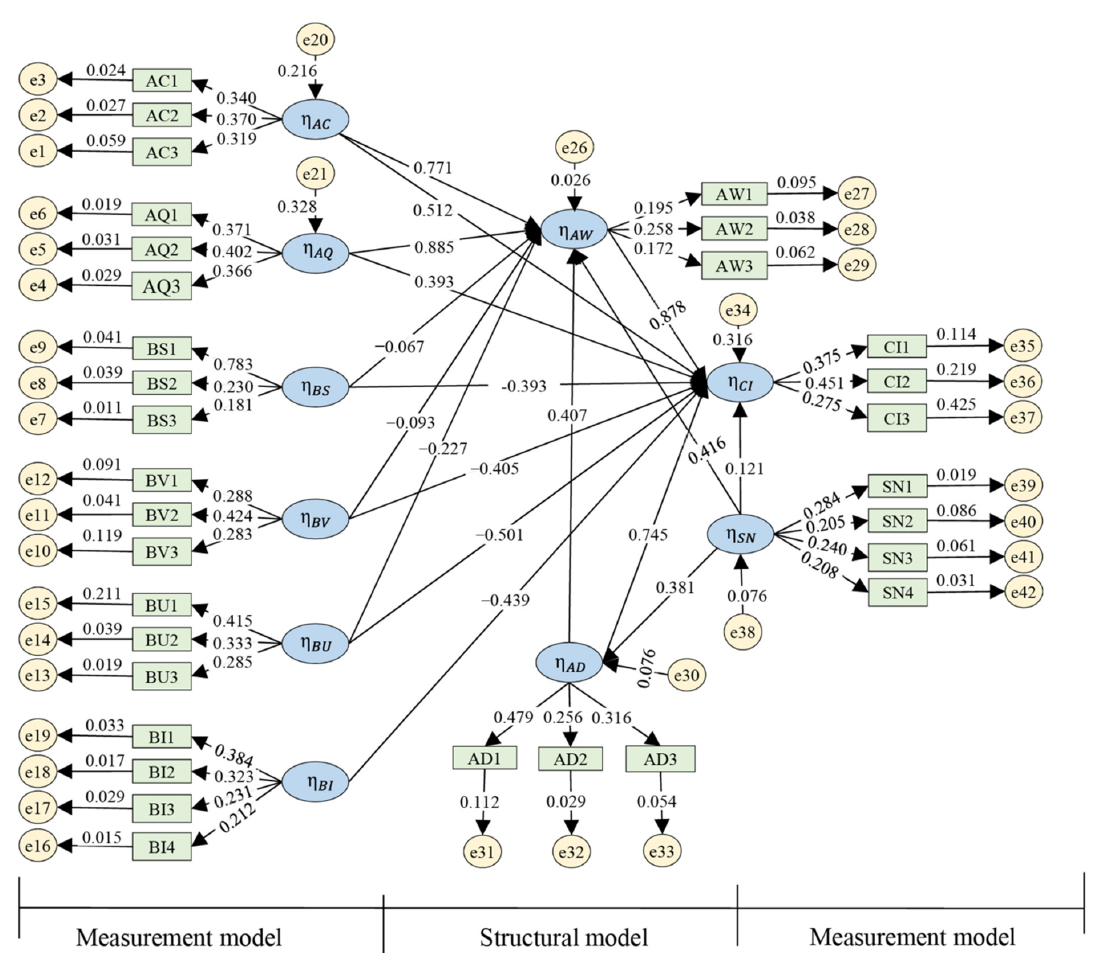
Figure 3. Path relationship between latent attitudinal variables in the MIMIC model. The goodness of fit index (GFI) of the MIMIC model is 0.953, the root mean square residual (RMR) is 0.028, and the root mean square error of approximation (RMSEA) is 0.012, indicating that these measures meet the acceptable criteria. The incremental fit index (IFI) = 0.925 and comparative fit index (CFI) = 0.917 exceed the ideal value of 0.9. The adjusted goodness of fit index (AGFI) = 0.944 is above the recommended value of 0.8. These indices indicate that the final MIMIC model is a good